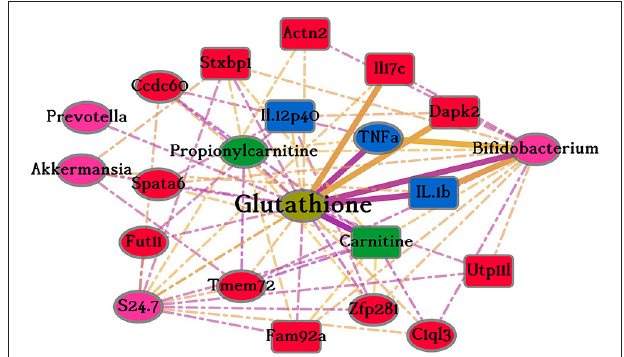
FIGURE 4 | Glutathione sub-network. This figure shows the 21 connections of the node Glutathione in the merged network. The different colors of nodes indicate the data-type of internal phenotypic level of that node, pink is Microbiota, red is Transcriptomics, blue is Cytokines, and green is Metabolites (light green—Metabolites from Serum and dark green—Metabolites from Urine). Oval nodes are connectivity hubs. Dotted lines show un-validated edges and continuous, thicker edges show connections also present in the results retrieved from scientific literature. Edge color, yellow and purple, indicates positive and negative correlations,